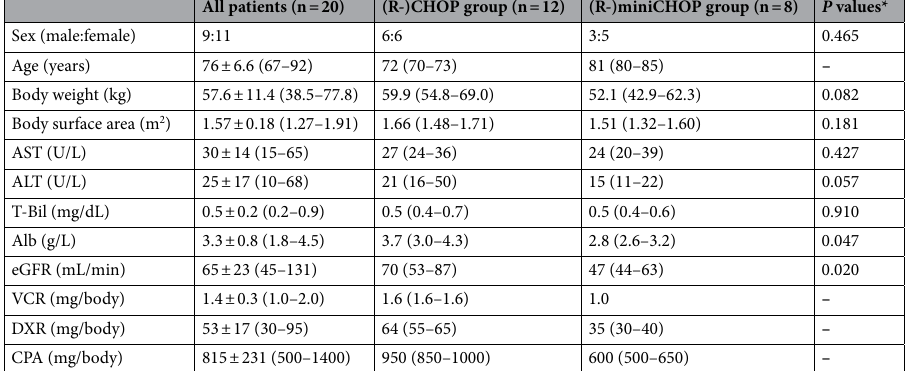
Table 1. Patient characteristics and administration dose of cytotoxic anticancer drugs. Alb, serum albumin; ALT, alanine aminotransferase; AST, aspartate aminotransferase; CPA, cyclophosphamide; DXR, doxorubicin; eGFR, estimated glomerular filtration rate; SD, standard deviation; T-Bil, serum total bilirubin; VCR, vincristine. Values are presented as mean ± SD (range) or median (quartile 1–quartile 3). *(R-)CHOP group vs. (R-)miniCHOP